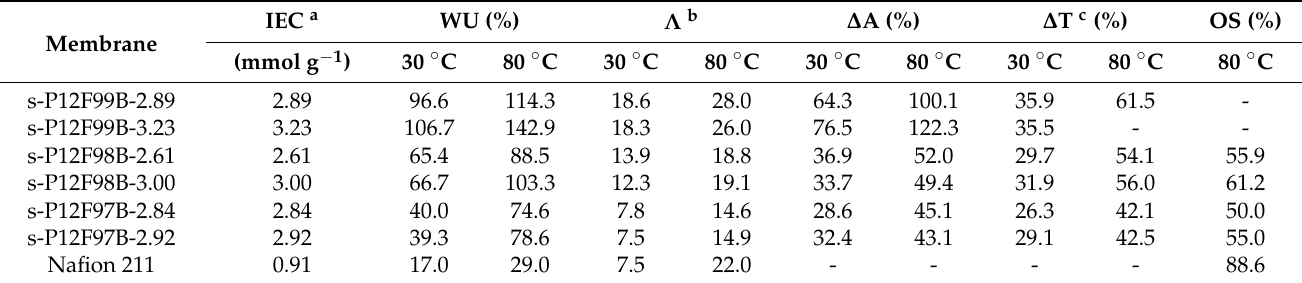
IEC represented by X cannot be mathematically averaged to express its significance, the average characterization and distribution are expressed as s-P12FmB-Ave. Table 2. IEC, water uptake, swelling, and oxidative stability of the s-P12FmB-X and Nafion 211 membranes. Membrane